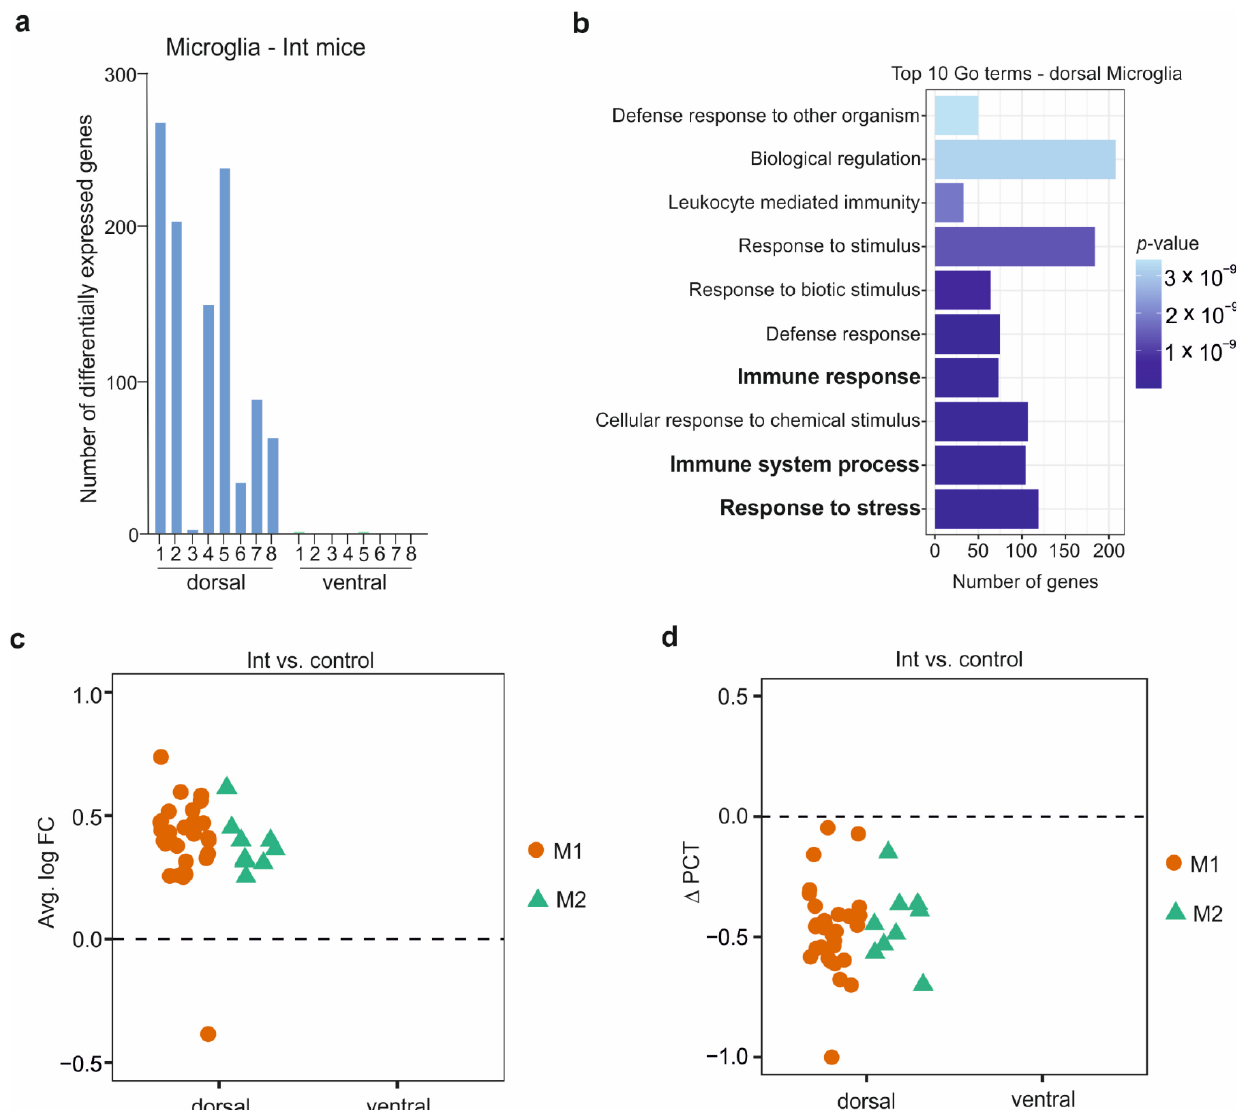
Figure 3. Chronic social defeat stress induces a microglia immune response in the hippocampal dorsal part of intermediate mice. ( a ) Number of DEGs among the microglial sub-clusters 1 to 8 in the intermediate mice compared to control mice in the dorsal and ventral parts of the hippocampus. ( b ) Top 10 GO terms analysis related to the DEGs identified in the dorsal hippocampus of the intermediate mice. The most relevant pathways are highlighted in bold. ( c ) Differential expression of M1 (Cxcl10, Fcgr2b, Fcgr3, H2-Aa, H2-D1, H2-Dmb1, H2-K1, H2-Oa, H2-Q4, H2-Q6, H2-T23, Tnf α ip2, Tnf α ip8l2, Il-1 β ) and M2 (Il-10r α , Socs3, Tgf β 1) markers in the dorsal and ventral parts of the hippocampus in the intermediate (Int) mice compared to control. ( d ) Difference in the percentage of cells ( ∆ PCT) expressing the M1 (Cxcl10, Fcgr2b, Fcgr3, H2-Aa, H2-D1, H2-Dmb1, H2-K1, H2-Oa, H2-Q4, H2-Q6, H2-T23, Tnf α ip2, Tnf α ip8l2, Il-1 β ) and M2 (Il-10r α , Socs3, Tgf β 1) markers in the dorsal and ventral parts of the hippocampus in the intermediate mice compared to control.